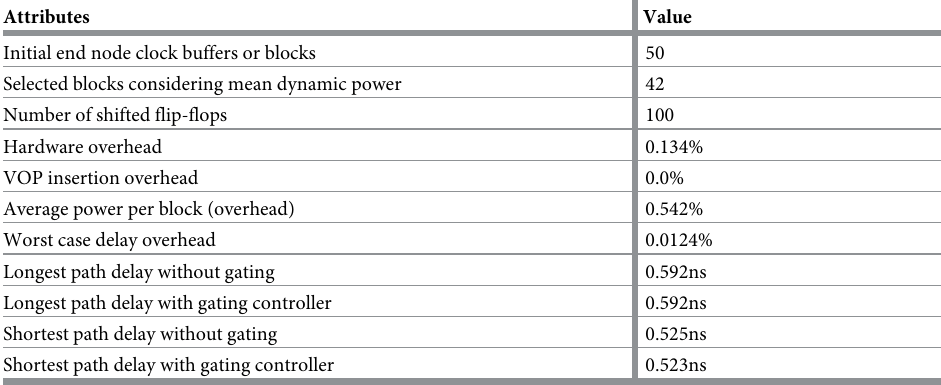
Table 1. Area, power and delay overhead of the AES-128 circuit with clock skew information.